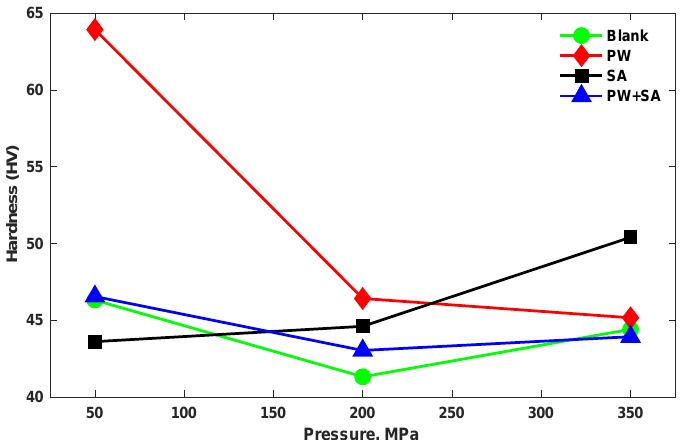
Figure 5. Hardness of the Cu–15Fe sintered composite powder samples, without and with different lubrication types, at various compaction pressures.